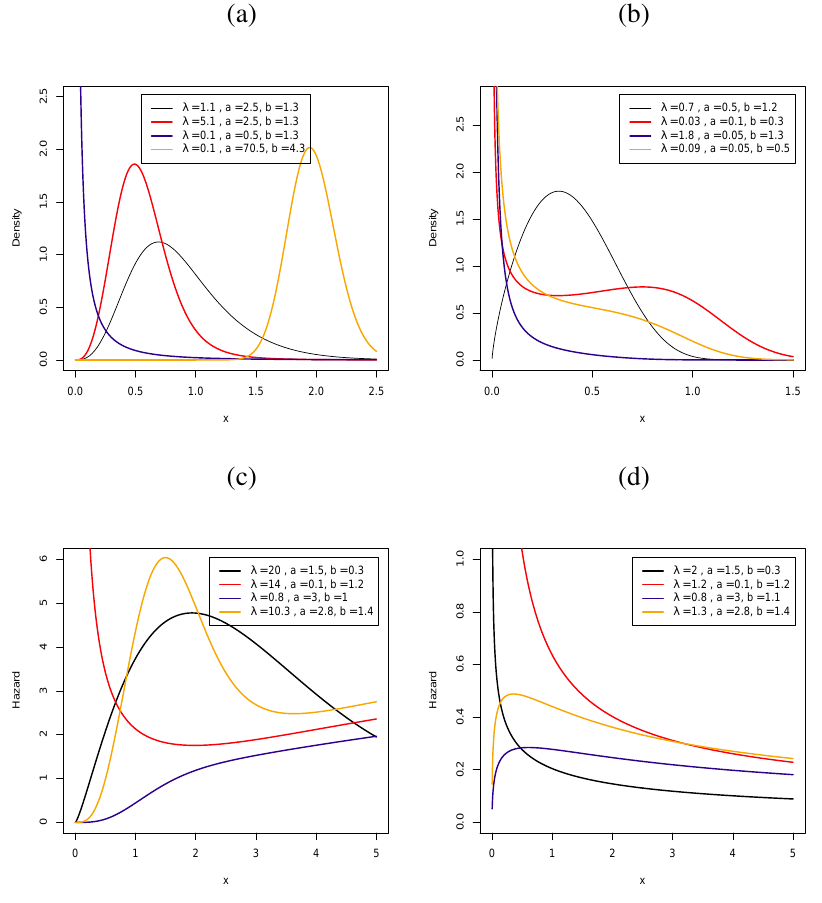
Fig. 1. Plots of the density and hrf of the Kw-WP distribution for some parameter values. (a) For c = 1 . 5 and β = 1 . 2. (b) For c = 1 . 5 and β = 0 . 4. (c) For c = 1 . 5 and β = 0 . 7. (d) For c = 0 . 5 and β = 0 .